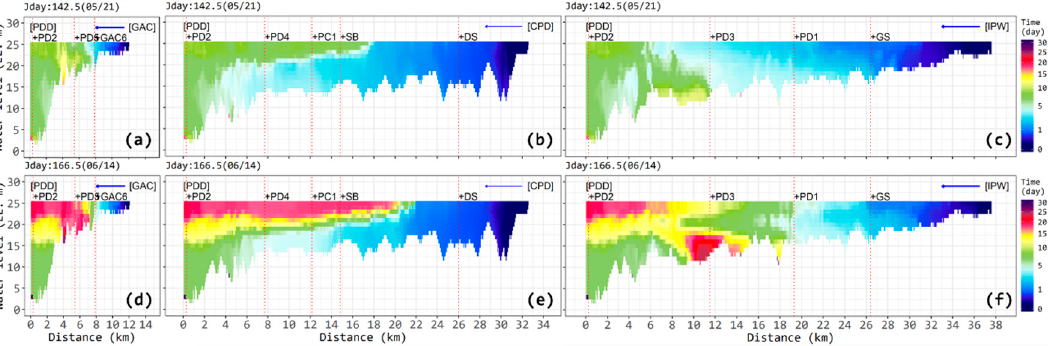
Figure 8. Longitudinal variations of water age on Julian day 142.5 ( a – c ) and 166.5 ( d – f ). Left snapshots from GAC to PDD; center snapshots from CPD to PDD; right snapshots from IPW to PDD. Jday and parentheses are the Julian day of year 2016 and month/day (format: mm/dd).